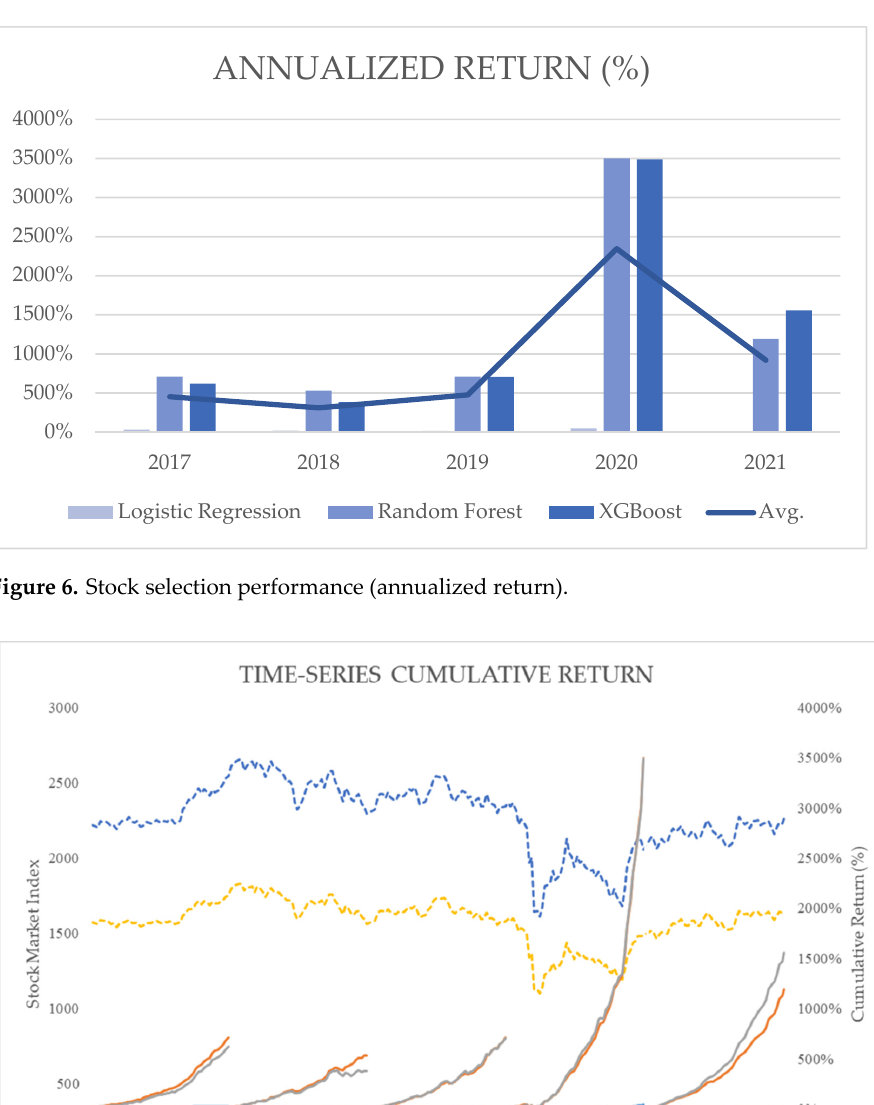
Figure 5. Stock selection performance (success prediction rate).